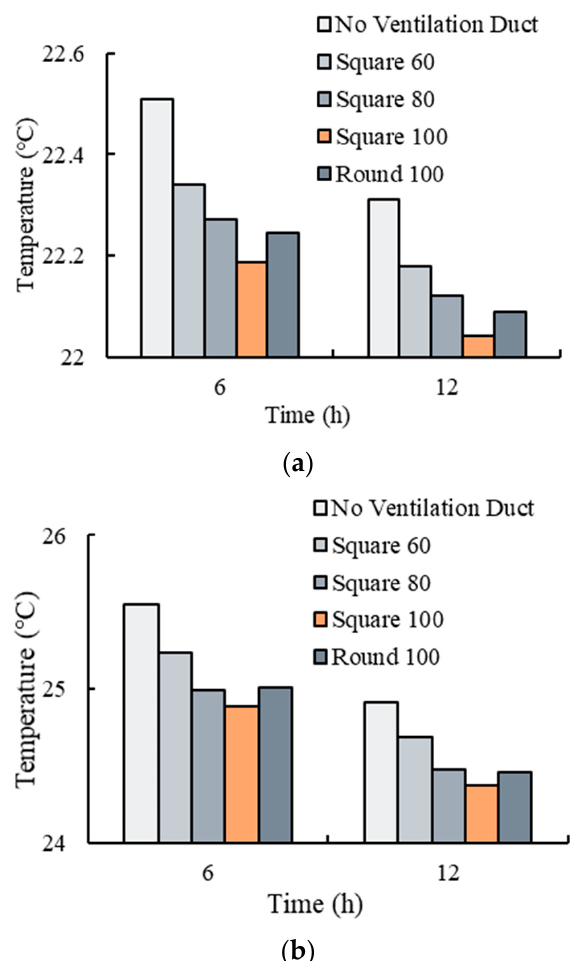
Figure 12. Temperature variations of the fresh tea leaves with different ventilation ducts: ( a ) average temperature; and ( b ) maximum temperature.